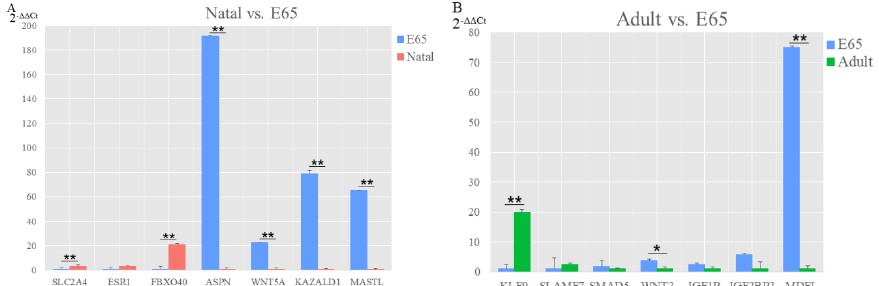
Figure 6. Validation of DEGs from three groups of pairwise comparisons by qRT-PCR. (A) Natal pigs vs. E65 pigs and (B) adult pigs vs. E65 pigs. Data presented in the y -axis indicate genes expression as determined by qRT-PCR. * p -value < 0.05; ** p -value < 0.01.